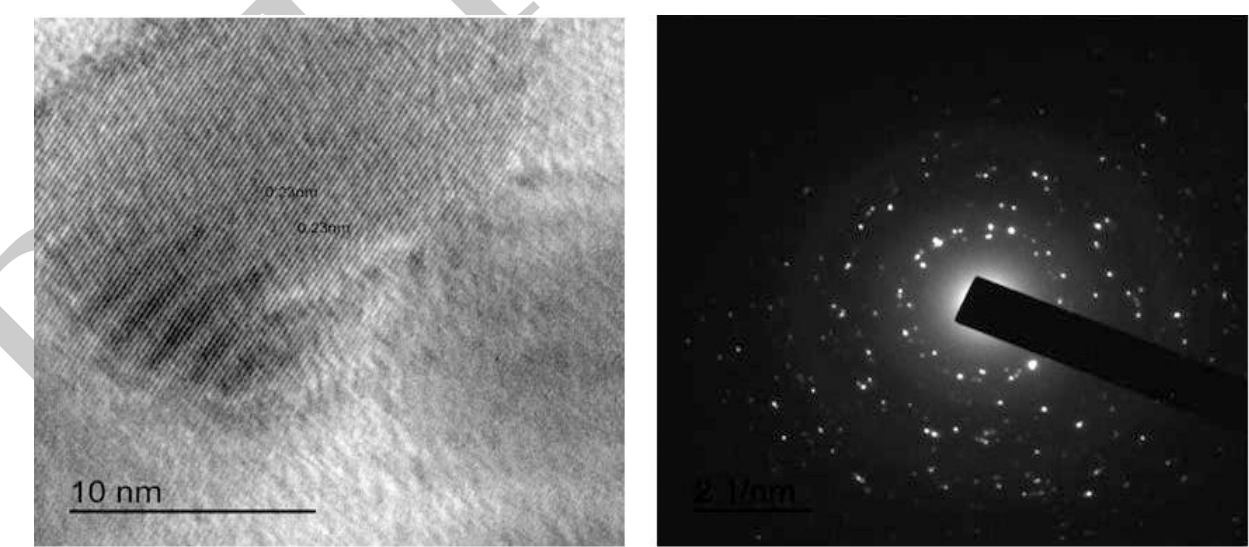
Figure 8. High Resolution Transmittance Electron Micrographs (HRTEM) images of ZnO-NPs shows a characteristic lattice space of 0.23 for the ZnO planes.